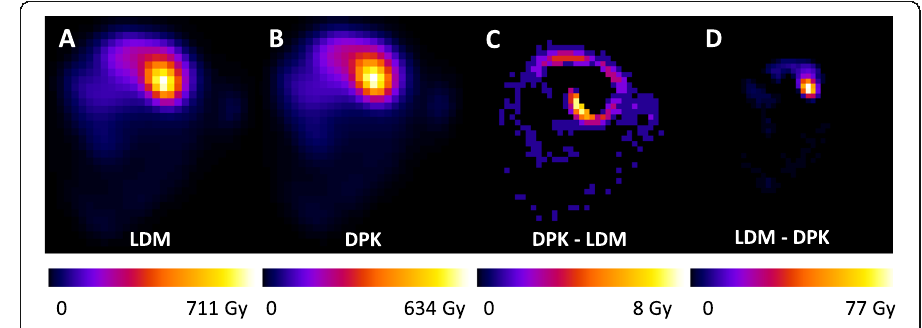
Fig. 10 Central coronal slice of the mean absorbed dose distribution map, for patient 9 determined by means of voxel dosimetry methods: LDM a and DPK b . Voxel based subtraction of parametric images (in Gy): DPK-LDM c and LDM-DPK d